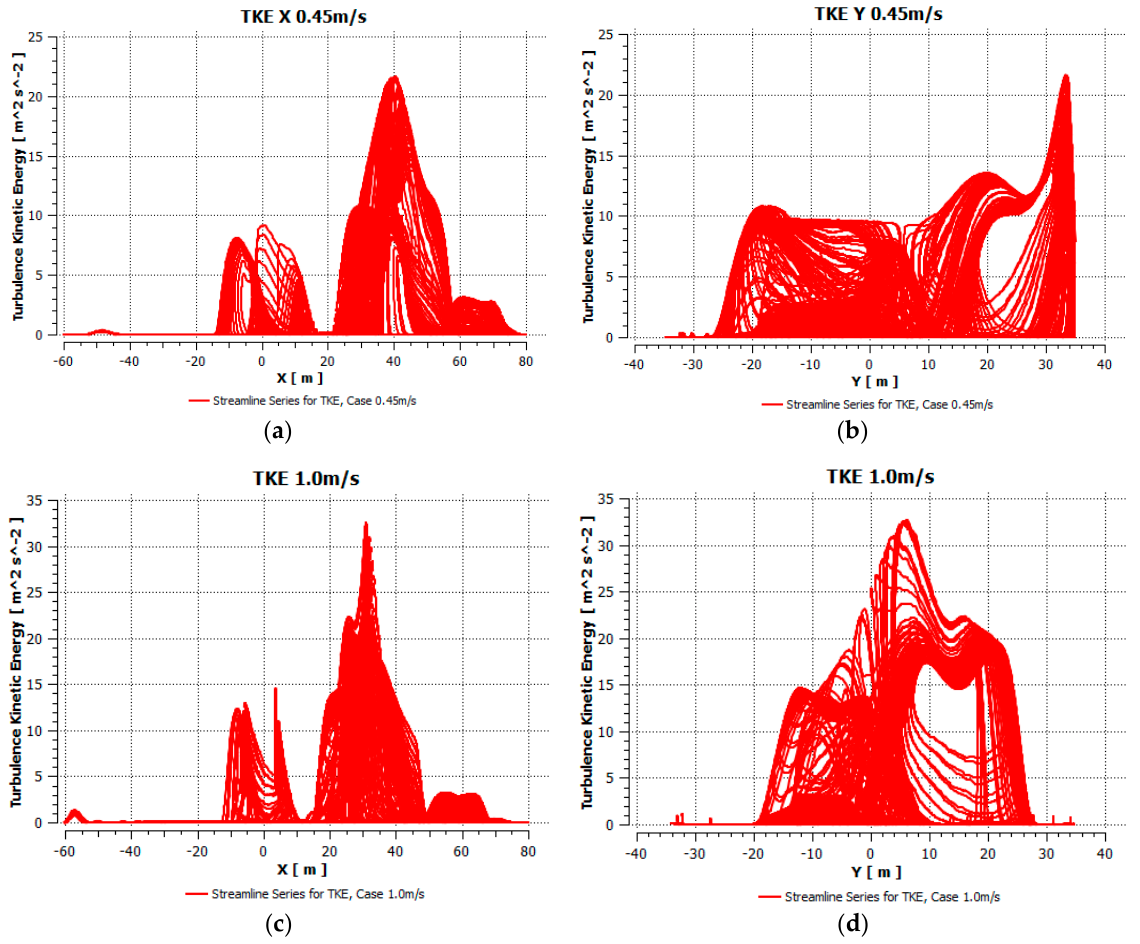
Figure 22. Turbulence profile for the flow on the buoy showing the streamline series: ( a , b ) Streamline series for Turbulence, case 0.45 m/s; ( c , d ) Streamline series for Turbulence, case 1.0 m/s.